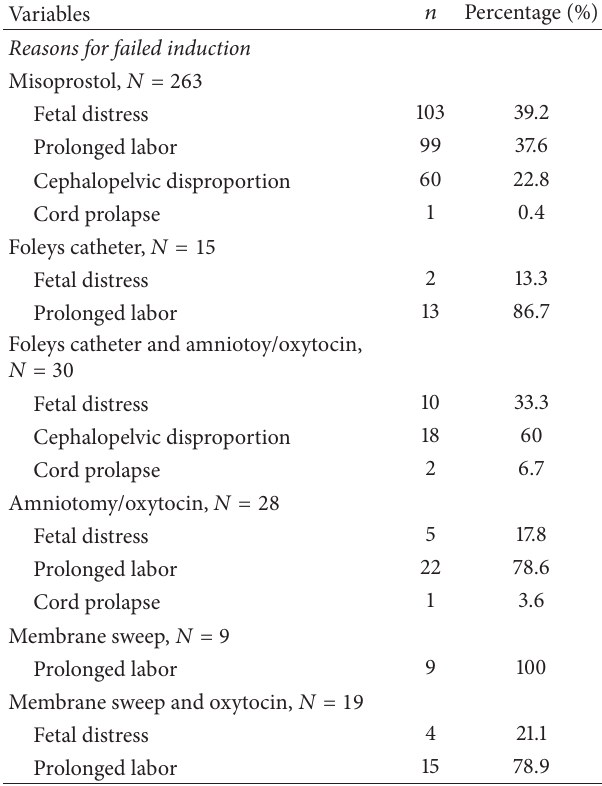
Table 4: Reasons for failed induction (𝑁 = 364)